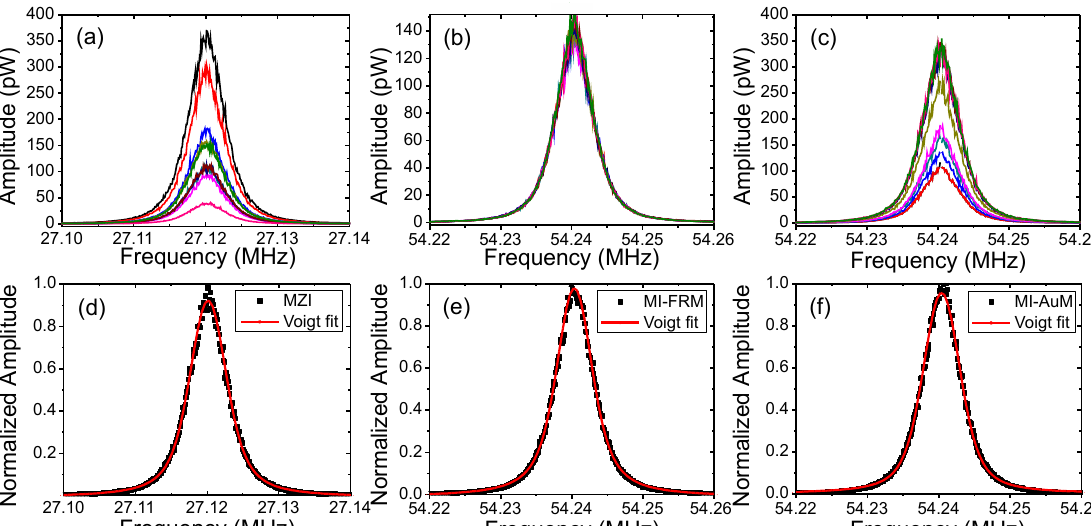
Figure 3. Beat spectra of 10 consecutive measurements each averaged 100 times for ( a ) MZI; ( b ) MI-FRM; and ( c ) MI-AuM at a DFB laser power of P = 116  W. Voigt fitting for one of 10 acquired beat spectra for the DFB power of 116  W for the ( d ) MZI; ( e ) MI-FRM; and ( f ) MI-AuM.